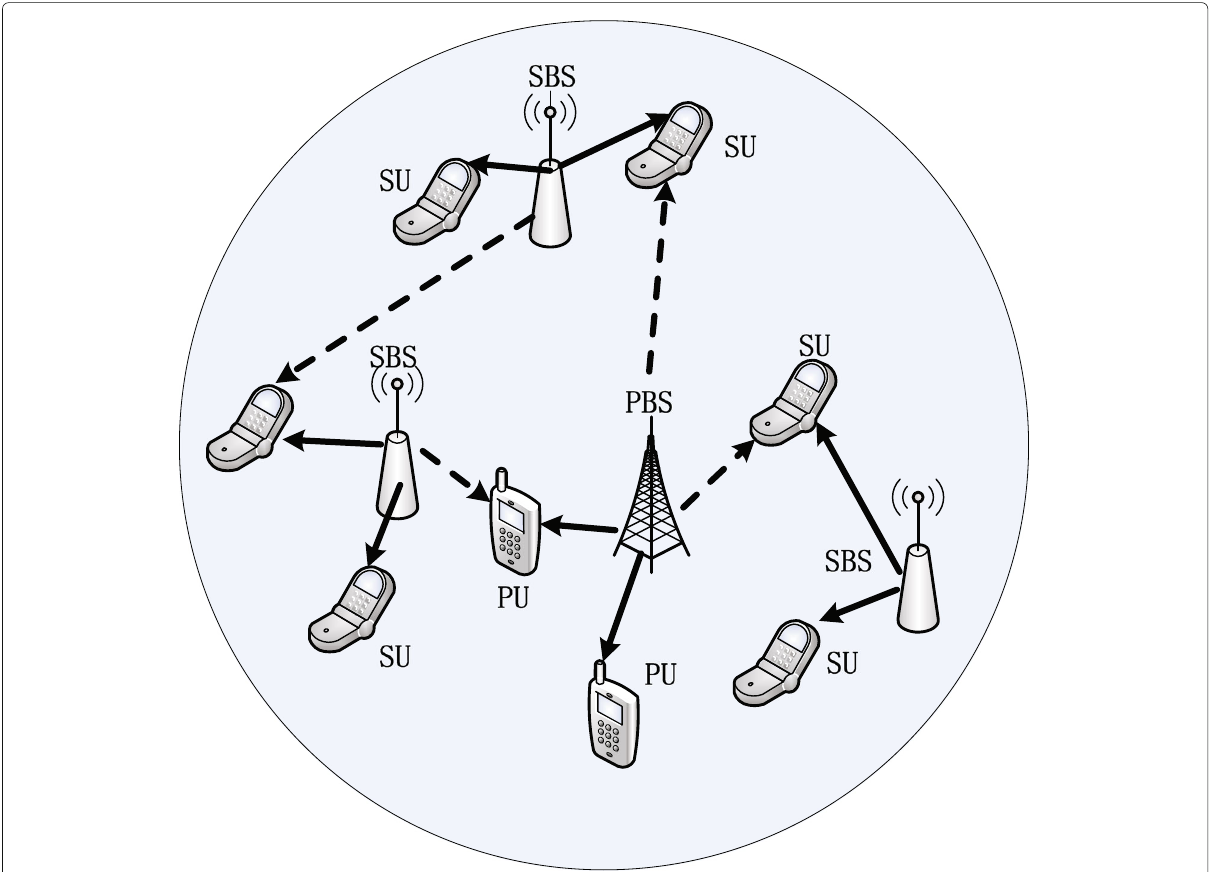
Fig. 1 System model. CR-enabled 5G system model containing one primary system and multiple secondary cells (The solid arrow lines denote the communication links and the dashed arrow lines denote the interference links, which include the interferences among secondary cells, secondary cells to the primary system and vice